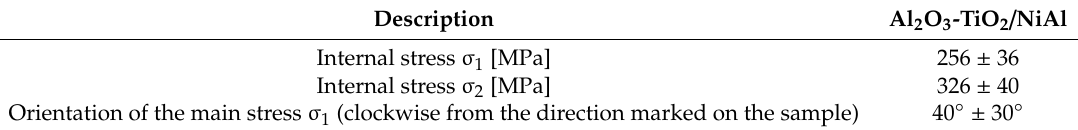
Table 5. Results of analysis of residual stresses in the Al 2 O 3 -15 wt.% TiO 2 / NiAl coating.